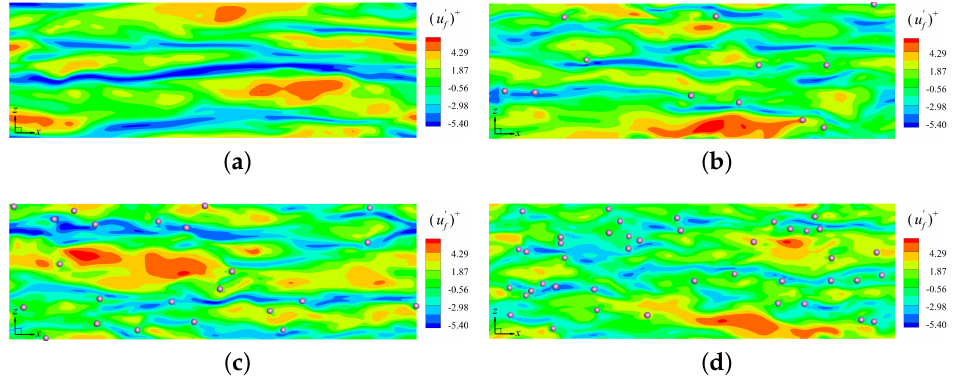
Figure 6. Snapshots of the streaky structures at y + = 13.8 plane: ( a ) Single phase, ( b ) φ = 0.11%, ( c ) φ = 0.22%, and ( d ) φ = 0.44%. Particles in contact with this plane are also shown.